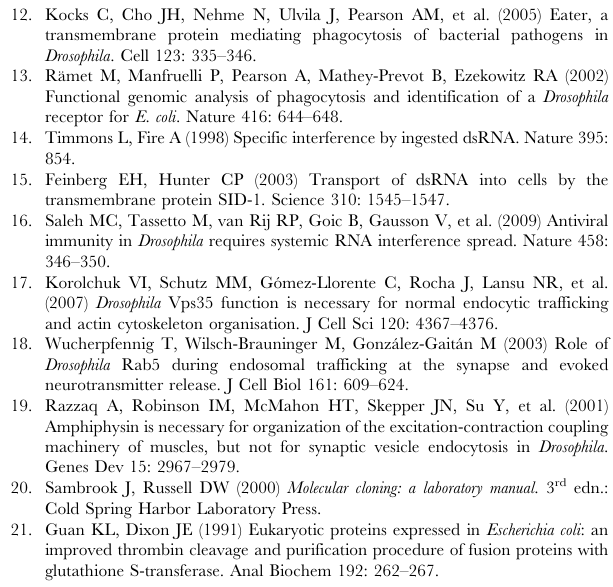
Figure S1 Inhibition of clathrin-mediated endocytosis inhibits both E. coli -mediated RNAi ( A ), and E. coli uptake in S2 cells ( B ). ( A ) Clathrin heavy chain (CHC) RNAi inhibits subsequent knockdown of amphiphysin using E. coli expressing amph dsRNA.